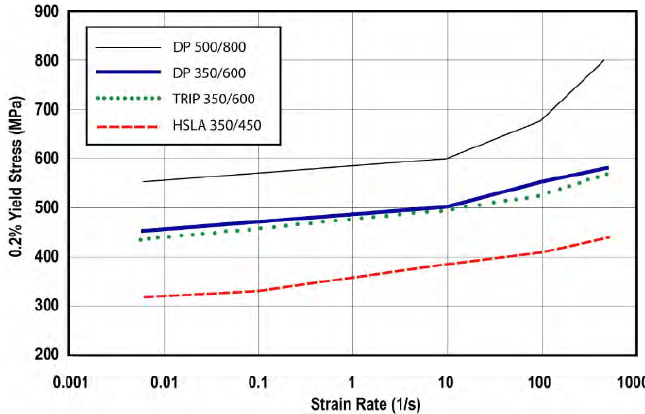
Figure 11. Increase in yield stress as a function of strain rate.